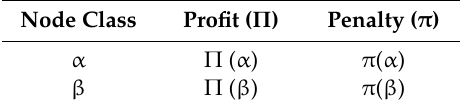
Table 4. The further division of profit and penalty.